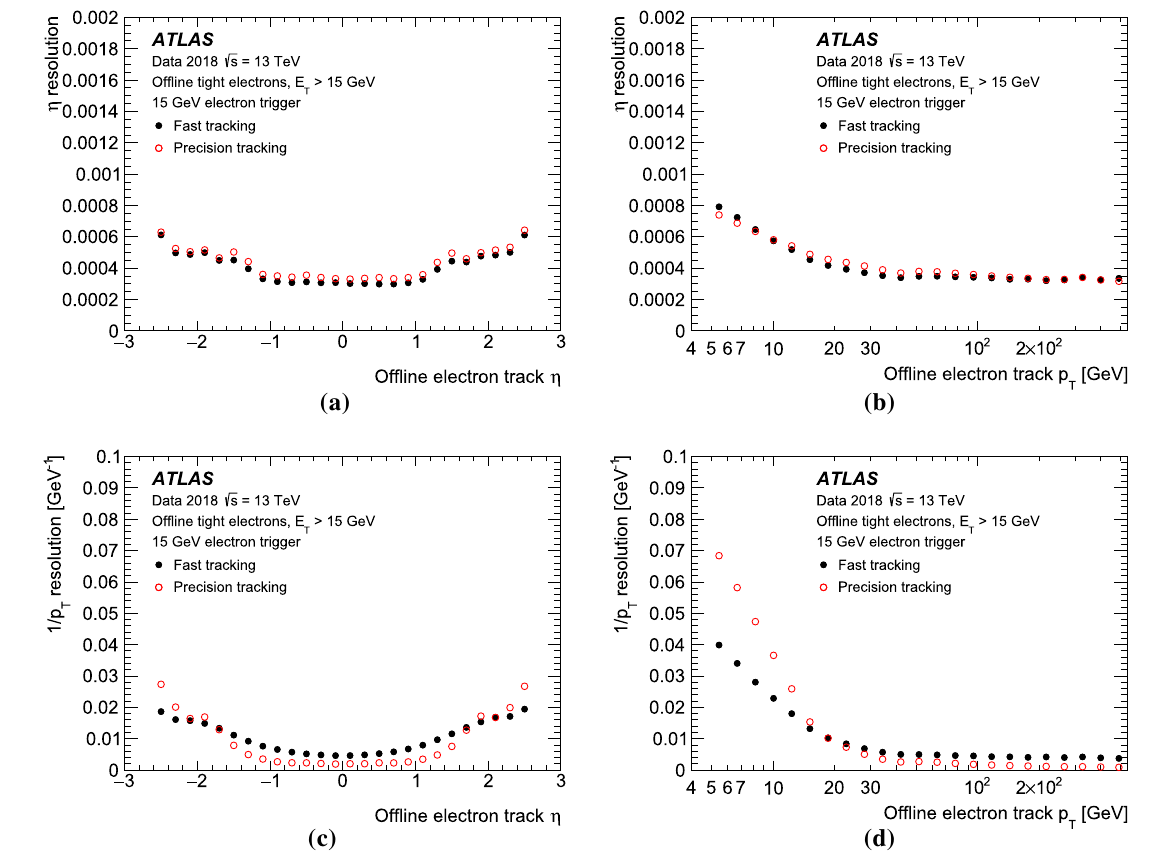
Fig. 29 The resolution in the pseudorapidity ( a , b ), and the inverse transverse momentum ( c , d ) as a function of offline track pseudorapid- ity and transverse momentum. The resolutions are shown for electrons